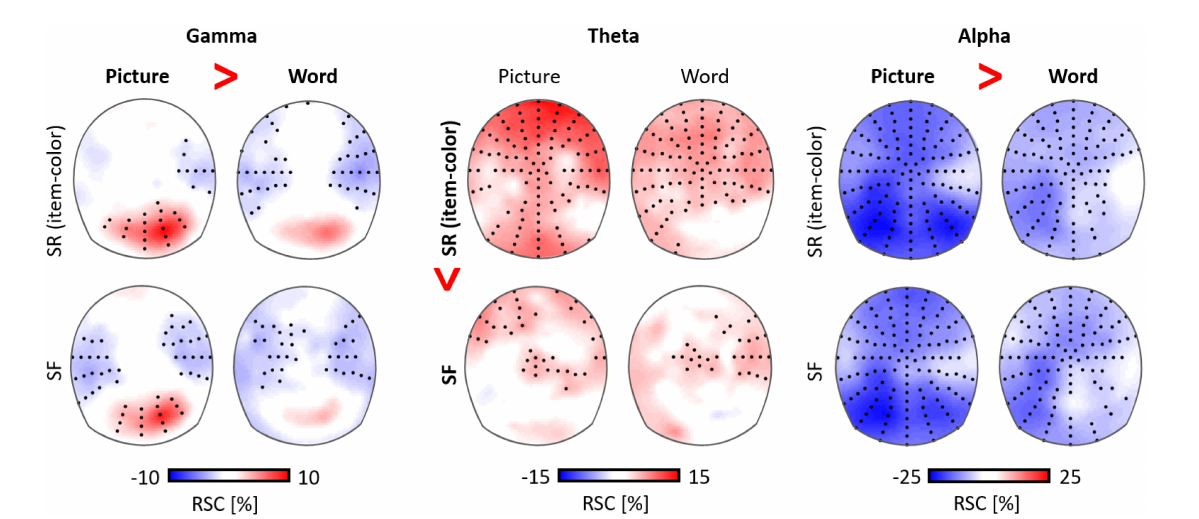
FIGURE4 Distinct functions of gamma, theta, and alpha oscillations in visual information processing (pictures versus words) and memory formation (item-color associations; Köster et al., 2018). Theta power was higher for subsequently remembered (SR) versus subsequently forgotten (SF) item-color associations, while parietal alpha suppression and gamma power were higher for pictures compared to words, but did not differ between encoding conditions (RSC: relative signal